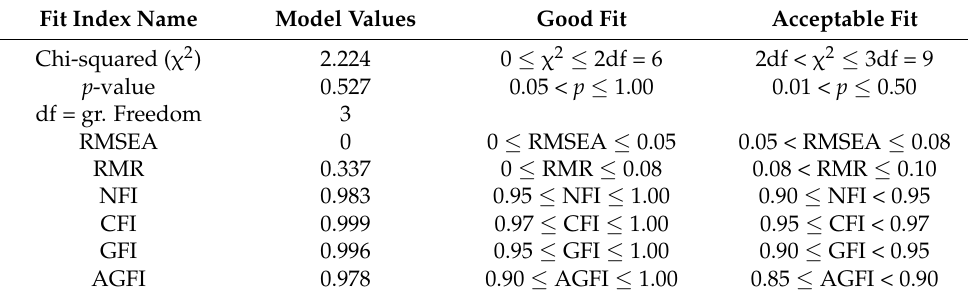
Table 9. Model adjustment rates associated with the final Path